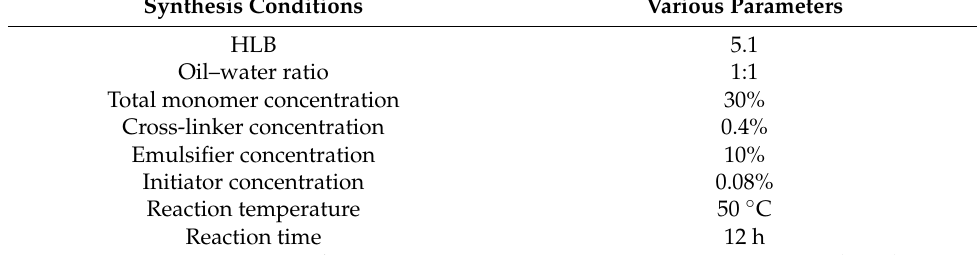
Table 3. The synthesis conditions of AMN other than monomer ratio.